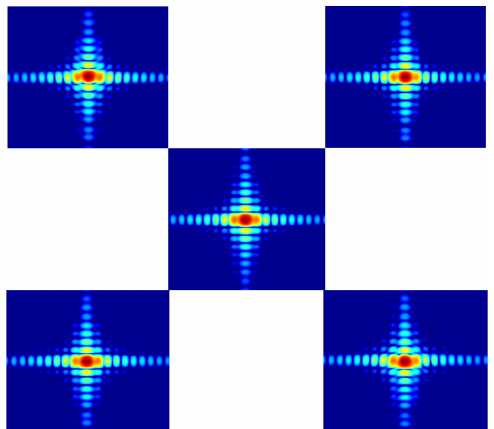
Figure 14. Imaging results of Case 1 without the BTD error compensation.